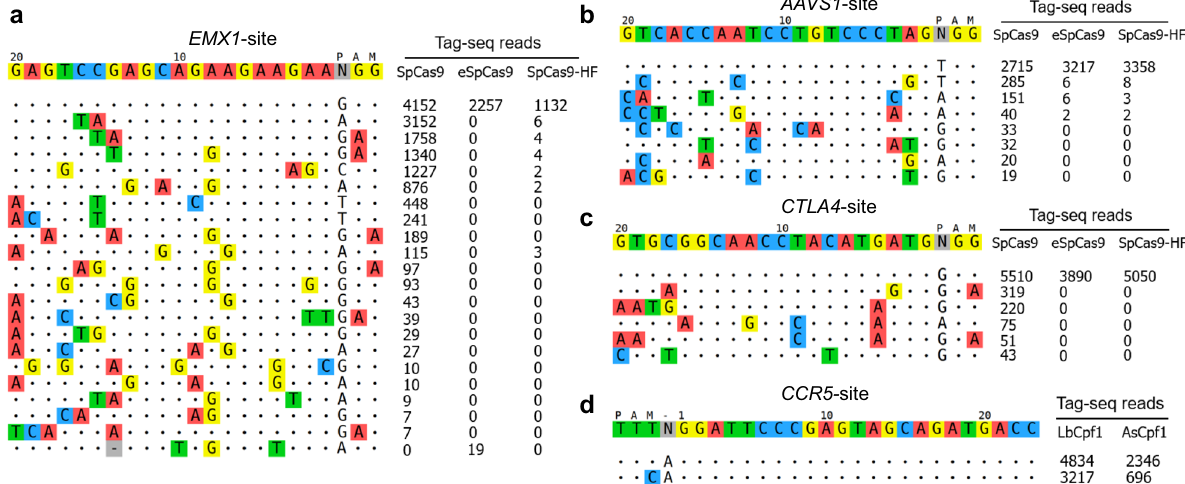
Fig. 5 Tag-seq assesses the speci fi city of CRISPR. a – c The speci fi city of wild-type Sp Cas9 and two high- fi delity variants (e Sp Cas9 and Sp Cas9-HF) were assessed at site EMX1 ( a ), AAVS1 ( b ), and CTLA4 ( c ). d The speci fi city of the As Cpf1 and Lb Cfp1 nucleases were assessed at site CCR5